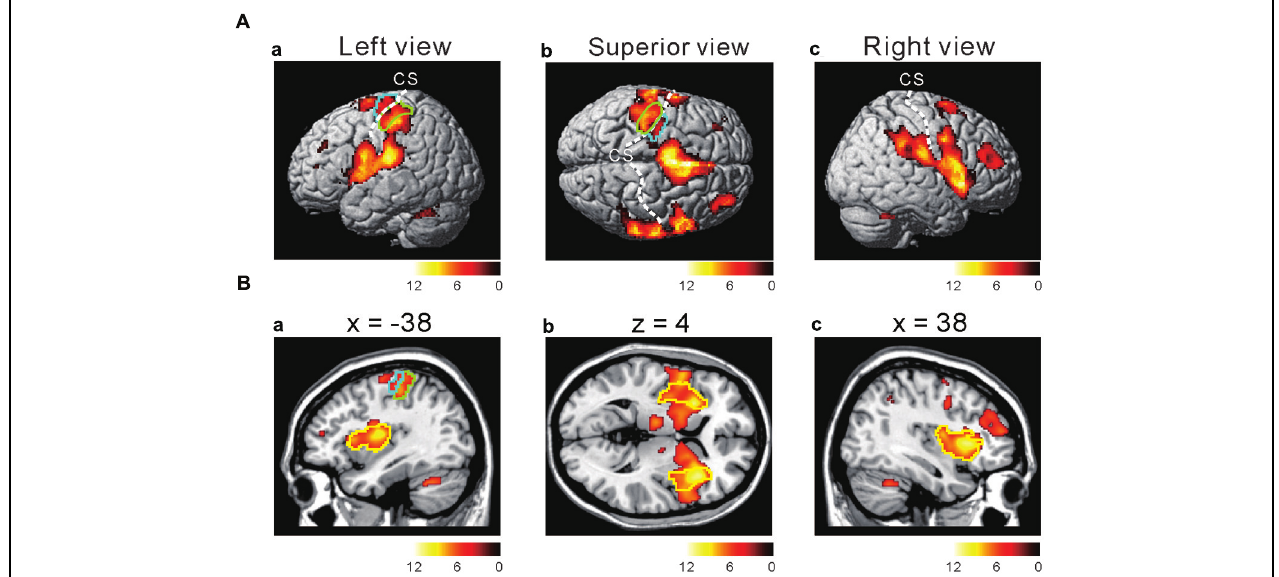
FIGURE 2 | Active brain regions revealed by a conjunction analysis. (Aa–c) Lateral (a,c) and superior (b) views after performing conjunction analyses of three different tastes responses [Capsaicin & NaCl & AS]. Green enclosed areas, postcentral gyrus (S1); Blue enclosed area, precentral gyrus (M1); CS, central sulcus. The color bar represents the T -values. (Ba–c) Sagittal (a,c) and horizontal (b) views after performing conjunction analyses of three different tastes responses [Capsaicin & NaCl & AS]. Green enclosed areas, postcentral gyrus (S1); Blue enclosed area, precentral gyrus (M1); yellow enclosed area, insula; CS, central sulcus. The color bar represents the T -values.